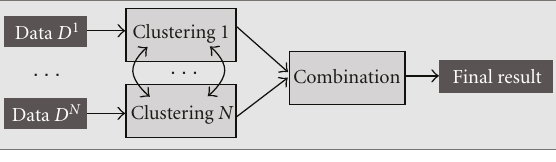
Figure 5: Di ff erent data fusion techniques.